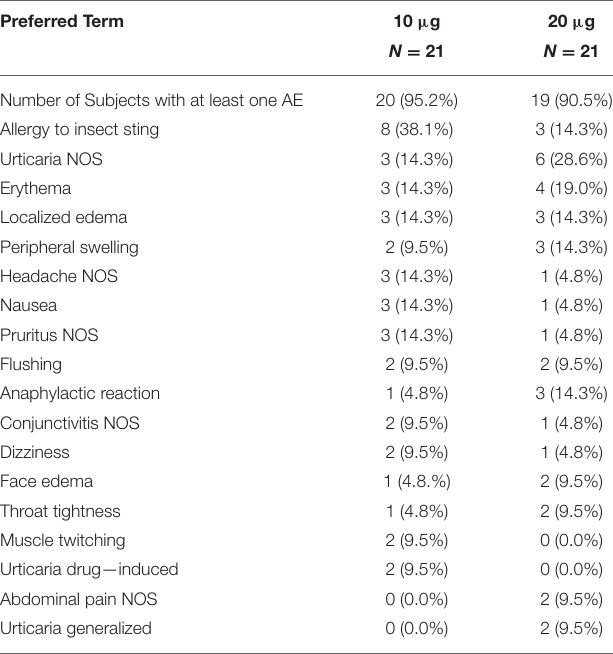
TABLE 3 | AEs in the safety population (reported for ≥ 5% of subjects in either treatment groups) during the bee sting challenge period by the preferred term and after completion of